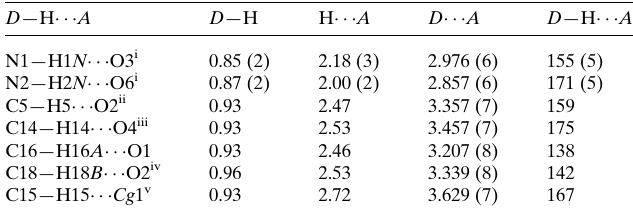
Table 1 Hydrogen-bond geometry (A˚ , (cid:3) ).